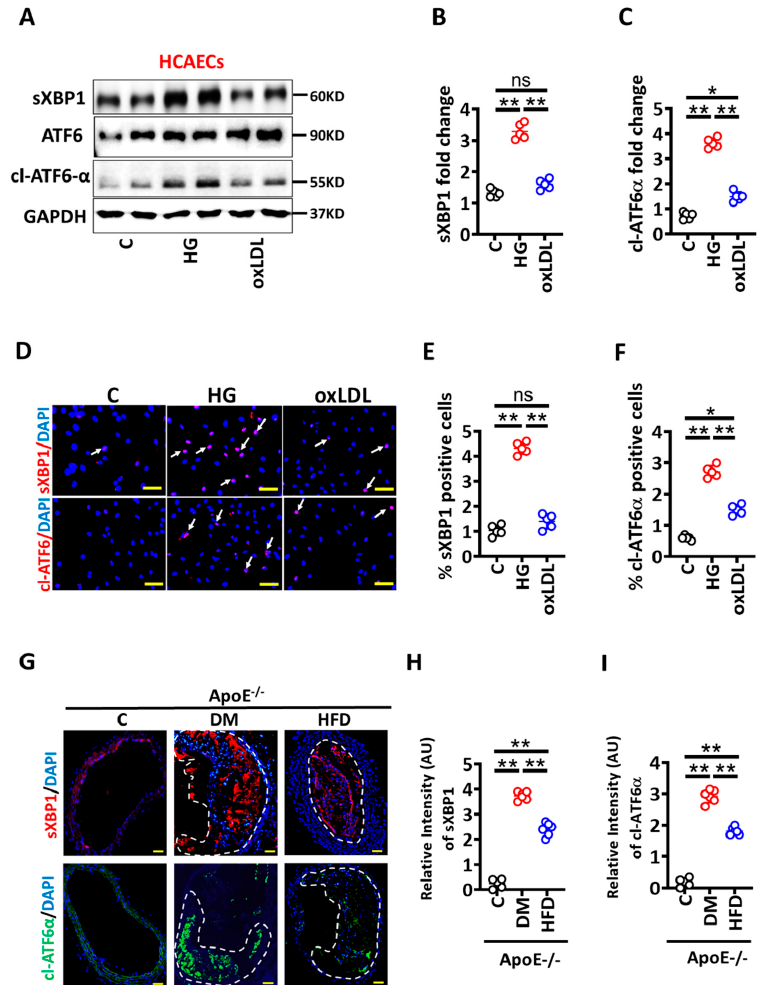
Figure 3. Hyperglycaemia induces UPR in endothelial cells and within plaques of diabetic ApoE − / − mice. ( A – C ) Representative immunoblots spliced XBP1 (sXBP1), total ATF6, and cleaved ATF6 alpha (cl-ATF6 α ) (( A ), loading control: GAPDH). Dot plots summarize densitometric quantifications of immunoblotting results for sXBP1 ( B ) and cl-ATF6 α ( C ). ( D – F ) Representative immunofluorescence images showing endothelial cells staining for sXBP1 (( D ), upper panel, red; nuclear counterstain: DAPI, blue) and cl-ATF6- α (( D ), lower panel, red; nuclear counterstain: DAPI, blue). Dot plots summarizing immunofluorescence data for sXBP1 ( E ) and cl-ATF6- α ( F ). Scale bar: 20 µm ( D ). ( G – I ) Representative immunofluorescence images showing staining of brachiocephalic arteries for sXBP1 (( G ), upper panel, sXBP1, red; DAPI nuclear counterstain, blue) and cl-ATF6- α (( G ), lower panel, cl-ATF6- α , green; DAPI nuclear counterstain, blue). Dot plots summarizing immunofluorescence data for sXBP1 ( H ) and cl-ATF6- α ( I ). Scale bar: 20 µm ( G ). HCAECs maintained under control ( C ), high glucose (25 mM; HG) or oxidized low density lipoprotein (oxLDL 50 µg/mL, oxLDL) conditions. Each dot represents data obtained from one biological specimen. ApoE − / − control mice (Cont, normal chow diet, citrate instead of streptozotocin injections), DM mice (normal chow diet, streptozotocin injections) or HFD mice (fed high fat diet). Each dot represents data obtained from one mouse specimen; * p < 0.05, ** p < 0.01, ns: non-significant; ANOVA.